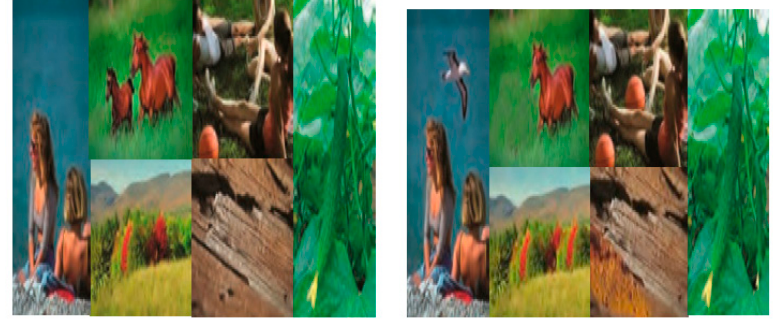
Figure 7. Forged image in CASIA ITDE v1. Table 2. Statistical information of spliced images.